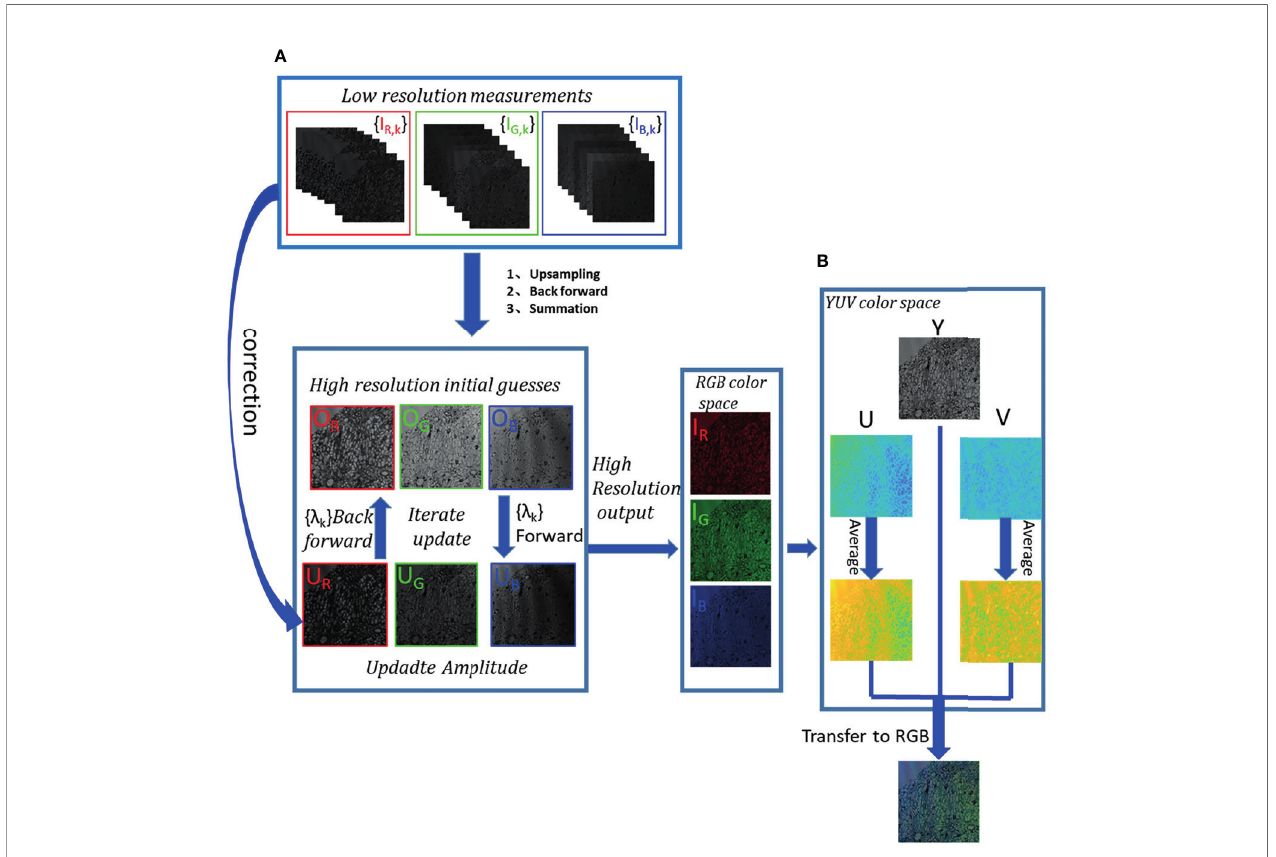
FIGURE 2 | Flow chart of multi-wavelength scanning pixel super-resolution and colour reconstruction. (A) After low-resolution measurement hologram stacks are up-sampled, backward-propagated and summed, a high-resolution initial guess is generated. The high-resolution object is iterated forward and backward in a sequence of wavelengths between the object surface and the image sensor plane. The measurement hologram is used to correct the wavefront amplitude of the image sensor plane, which is calculated by the forward propagation from the object plane to the image sensor plane. The object wavefront is updated by the backpropagation calculation from the image sensor plane to the object plane. And then, the phase relationship is used to correct the phase. Finally, the phase retrieval high-resolution reconstructed images of R, G and B channels are obtained. (B) A high-resolution RGB image from the RGB colour space to the YUV colour space is converted. With U and V components being average- fi ltered, respectively, the Y component remains unchanged. Then, the updated U and V are converted into the RGB space together with Y to generate a high-resolution colour reconstruction image that eliminates rainbow-like